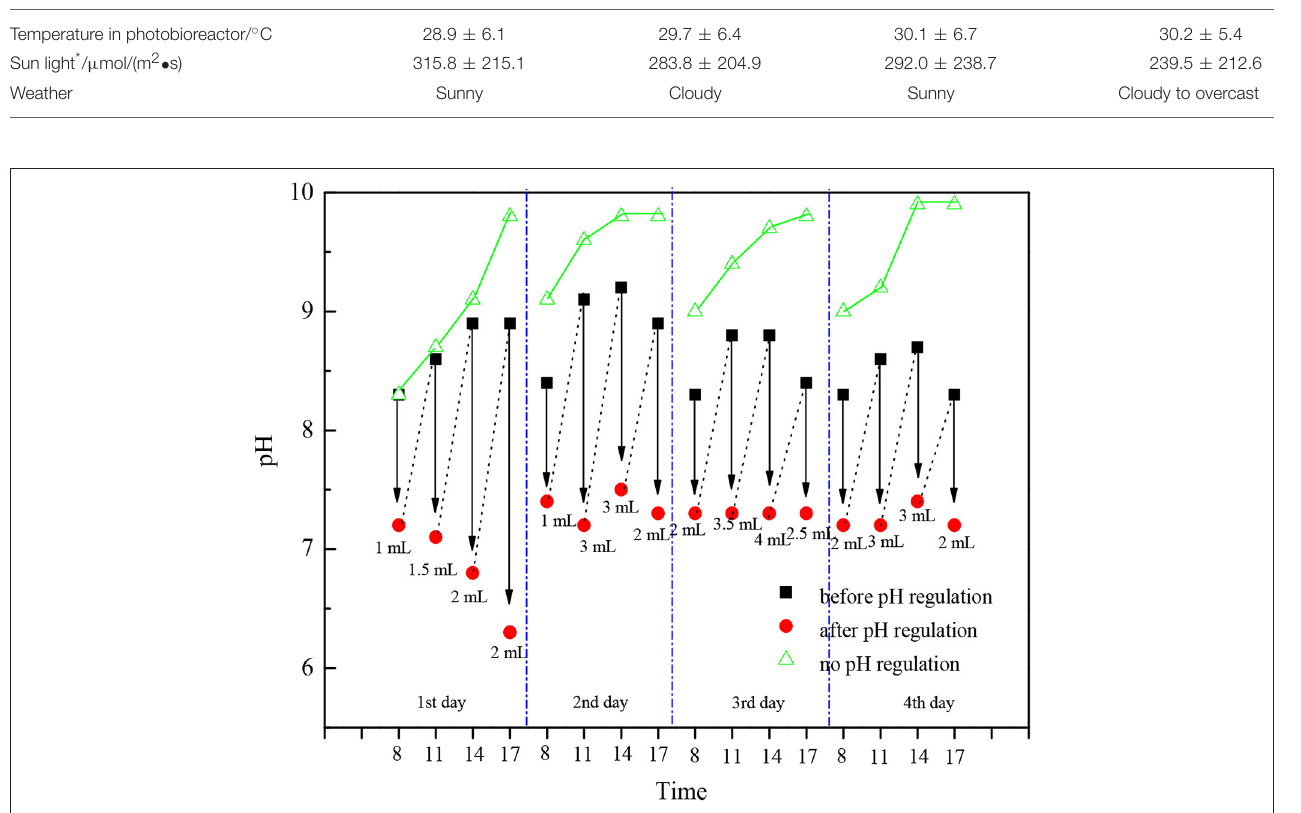
FIGURE 6 | The pH changes under only air ventilation or HAc